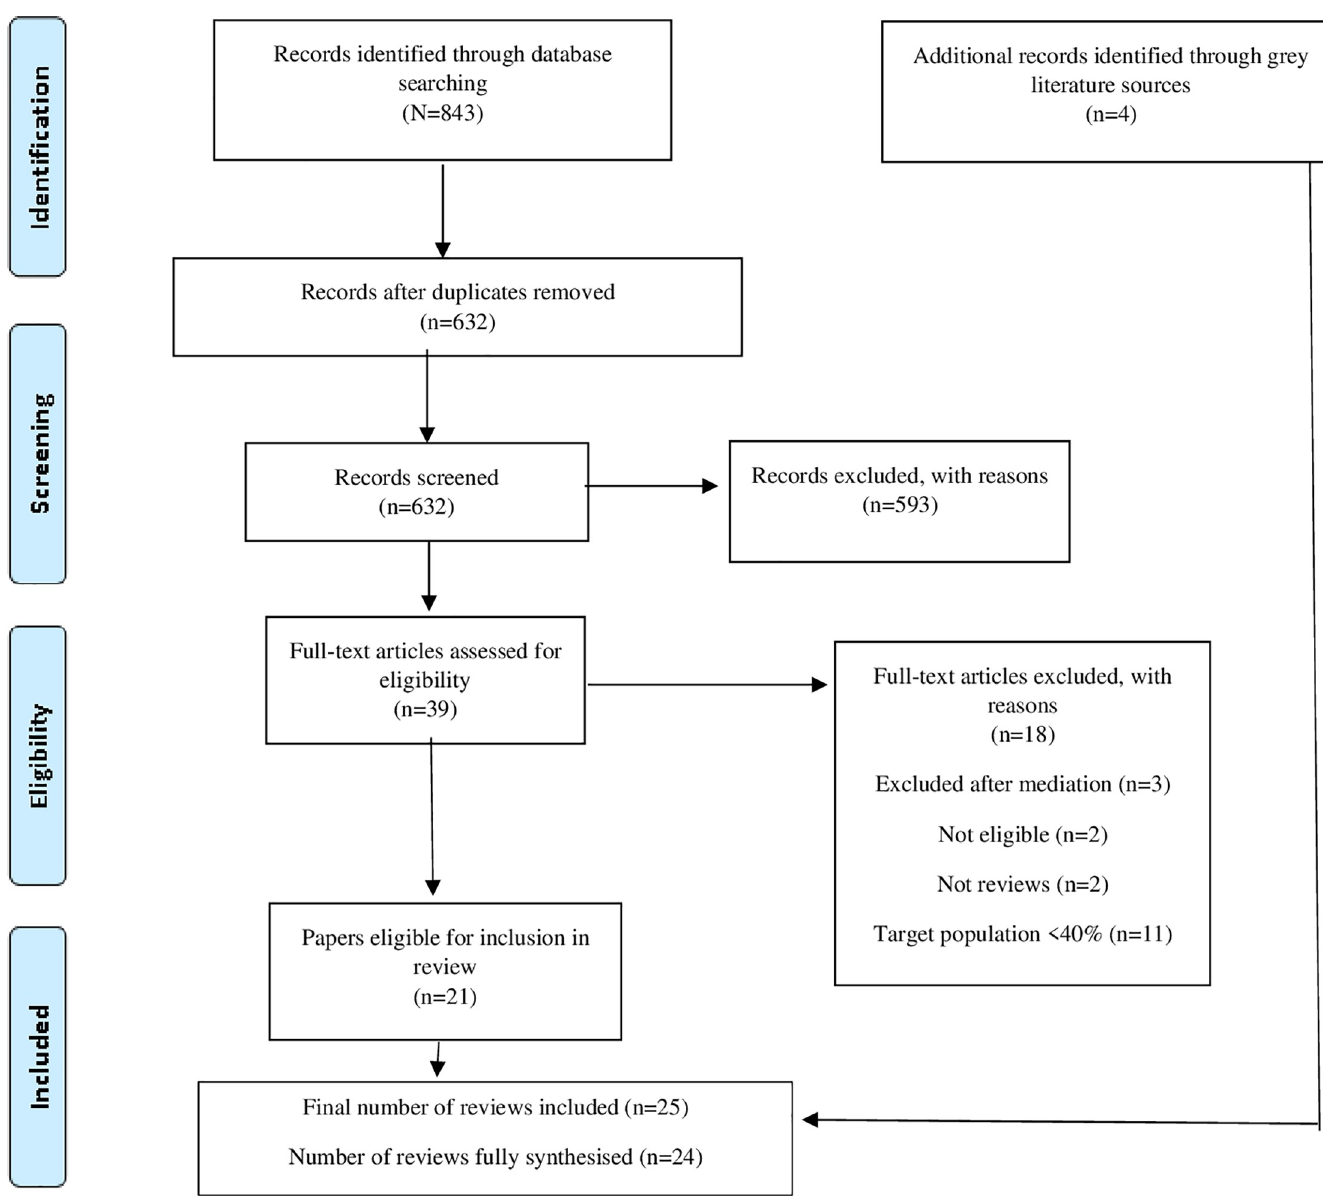
Fig 1. PRISMA flow